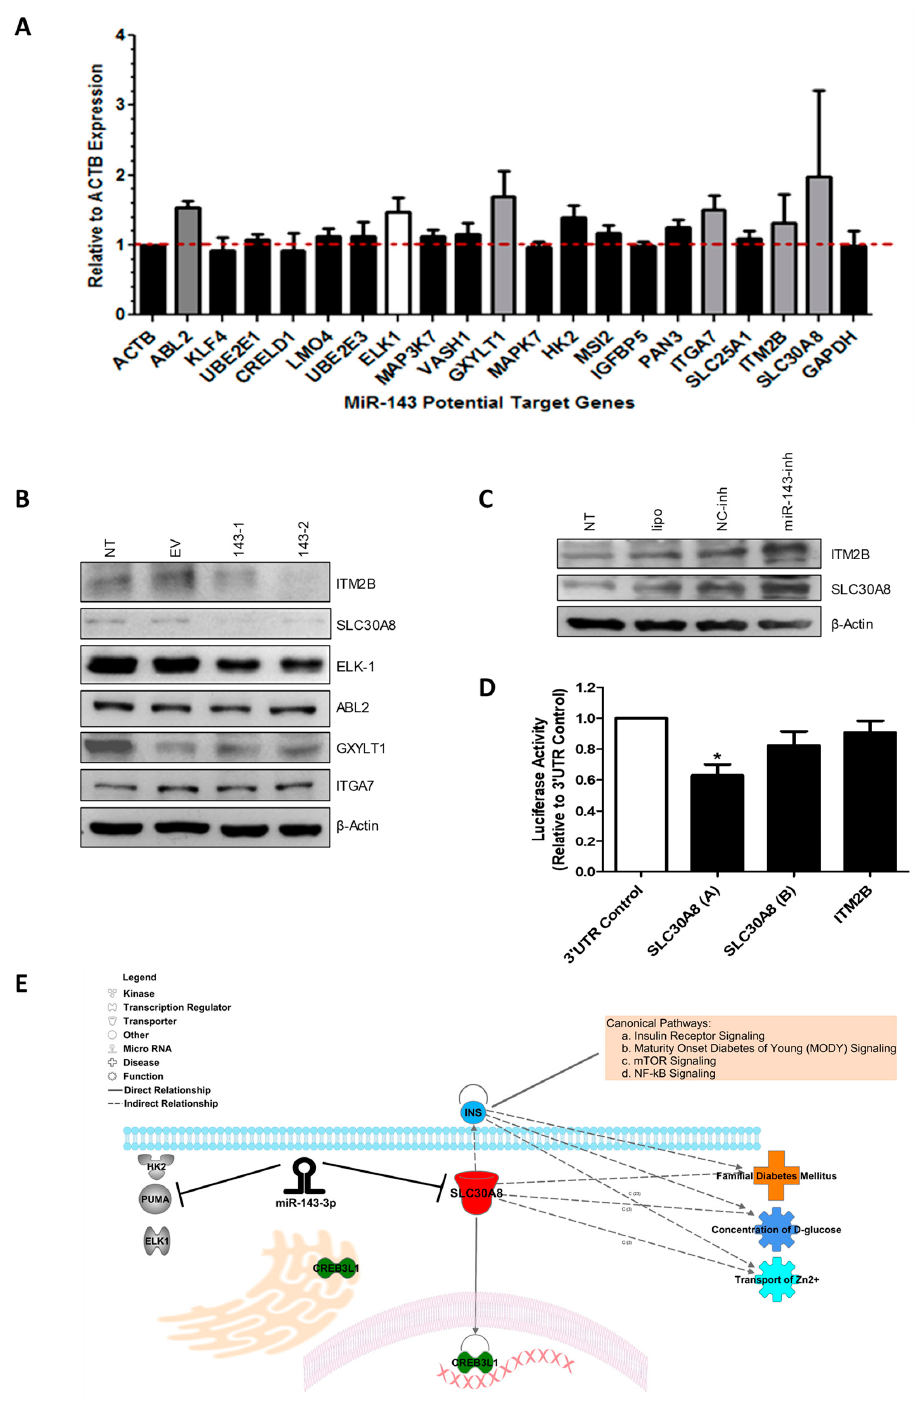
Figure 4. Identification of miR-143 target genes in GBM cells. ( A ) SYBR Green-based qPCR was performed with total RNA isolated from T98G cells transiently transfected with miR-143-inh or NC-inh. ( B ) Western blot analysis was performed with protein extracts from miR-143 overexpressed (143-1, 143-2) and EV clones. ( C ) Western blot analysis of protein extracts from U87 cells treated with 200 nM miR-143-inh or NC-inh, Non-treated cells (NT), and U87 cells with transfection reagent alone (lipo) as loading controls. ( D ) Dual-luciferase reporter assays were performed where luciferase activity was calculated relative to the NC-inh. ( E ) IPA analysis showing the interaction of miR-143 with its target genes and SLC30A8 association with glucose metabolism.